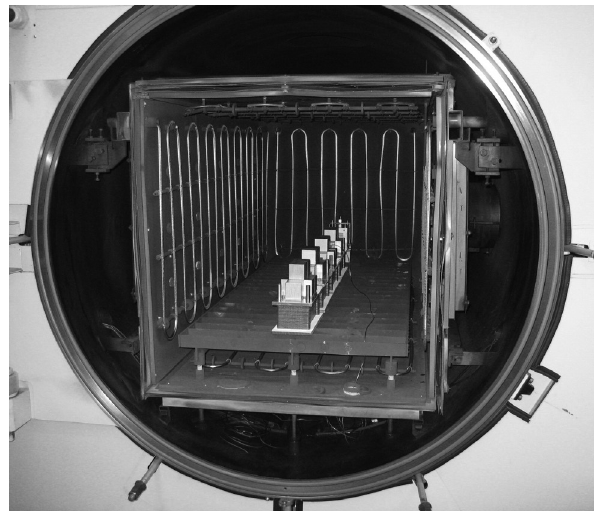
Figure 13 Stacks burdened with weights inside the vacuum oven.